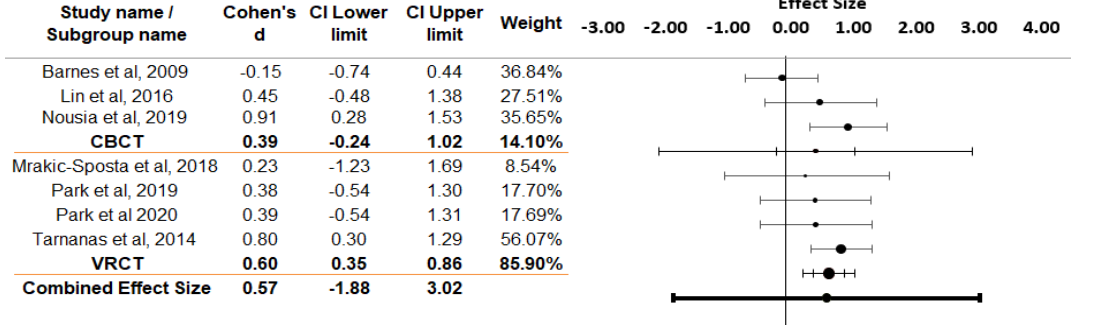
Figure 4. Forest plot of Lang. Figure 3. Forest plot of executive function (EF). Figure 4. Forest plot of Lang. Figure 4. Forest plot of Lang.